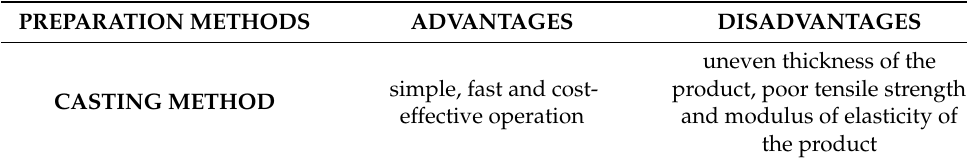
Table 2. Advantages and disadvantages of the three preparation methods. PREPARATION